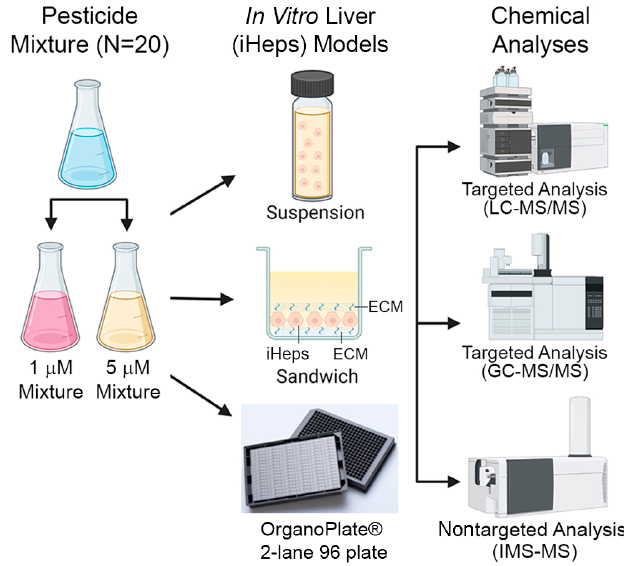
Figure 1. Experimental design. Schematic diagram describing the chemical mixture tested across different in vitro liver models (suspension, 2D sandwich, and OrganoPlate ® 2-lane 96) and types of chemical analyses used in this study.